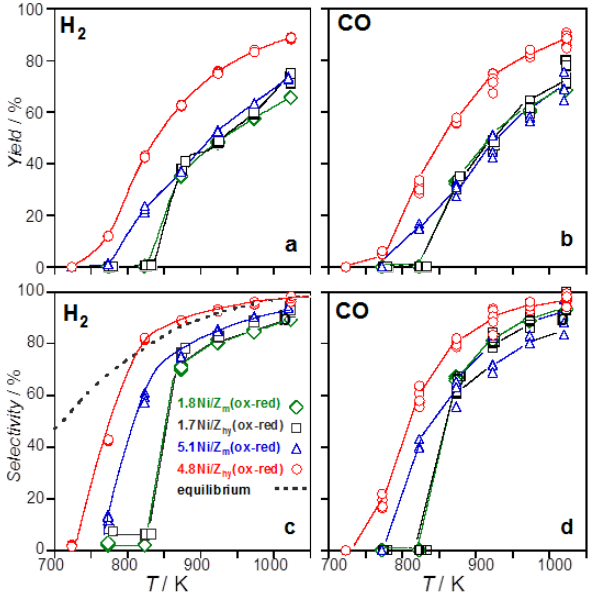
Figure 12. Comparison of activity and selectivity for Ni/ZrO 2 catalysts after ox-red activation treatment. H 2 yield and selectivity ( a , c ) and CO yield and selectivity ( b , d ) as a function of temperature. Reactant mixture: [CH 4 ] = 2%, [O 2 ] = 1%, N 2 as balance; total flow rate = 150 cm 3 (STP)·min −1 . Dotted line: H 2 selectivity for the same mixture calculated at thermodynamic equilibrium (data from Ref. [11]).